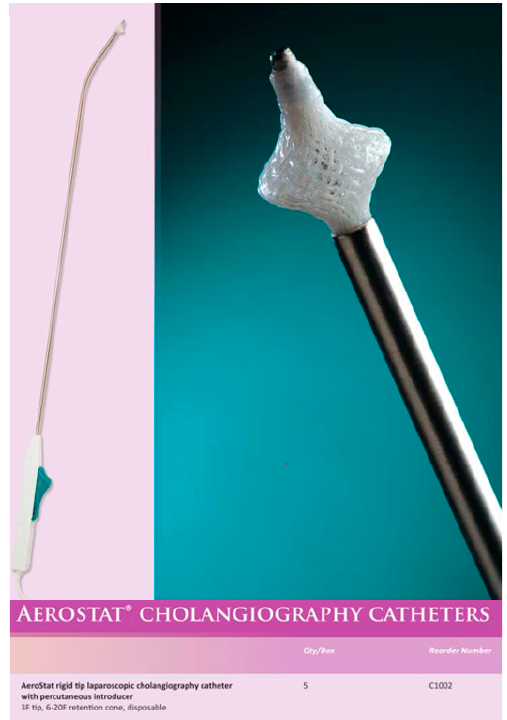
Figure 1. AeroStat rigid tip laparoscopic cholangiography catheter.